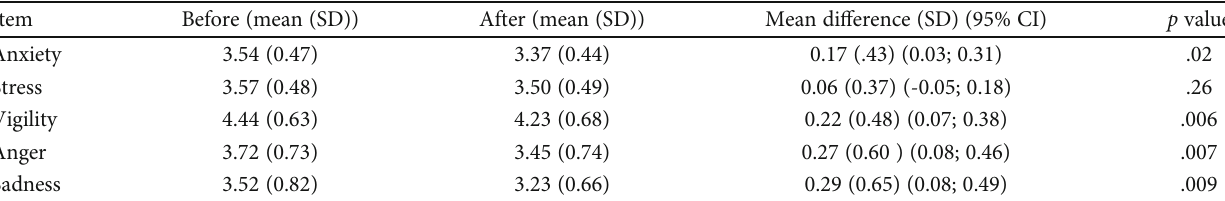
Table 1: Mean di ff erences between before and after use of